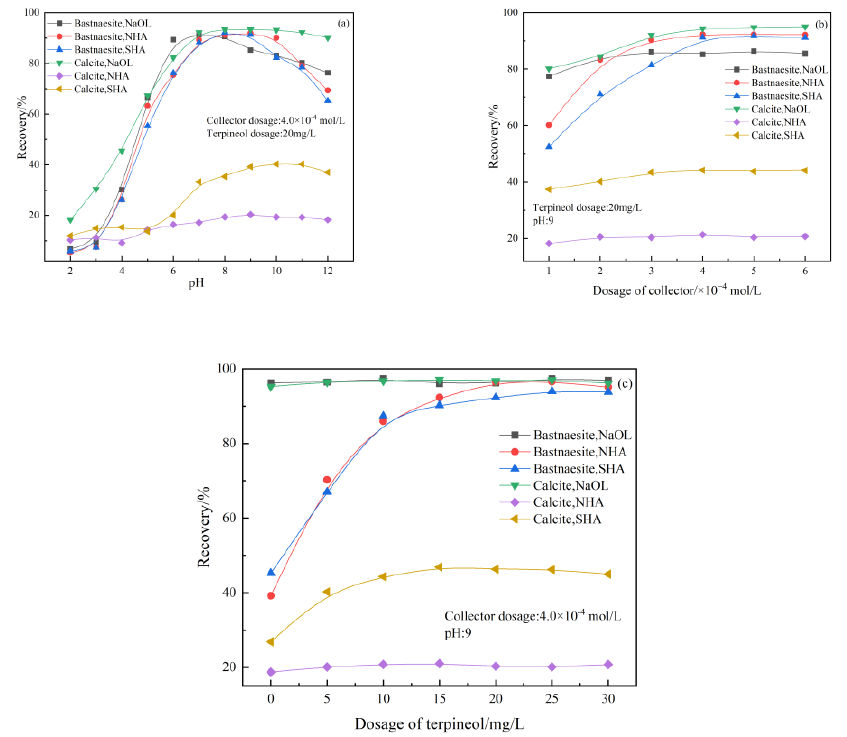
Figure 4. Recoveries of bastnaesite and calcite as a function of pH ( a ), and dosages of NaOL,2-OH-3-NHA, SHA ( b ) and terpineol ( c ), respectively.